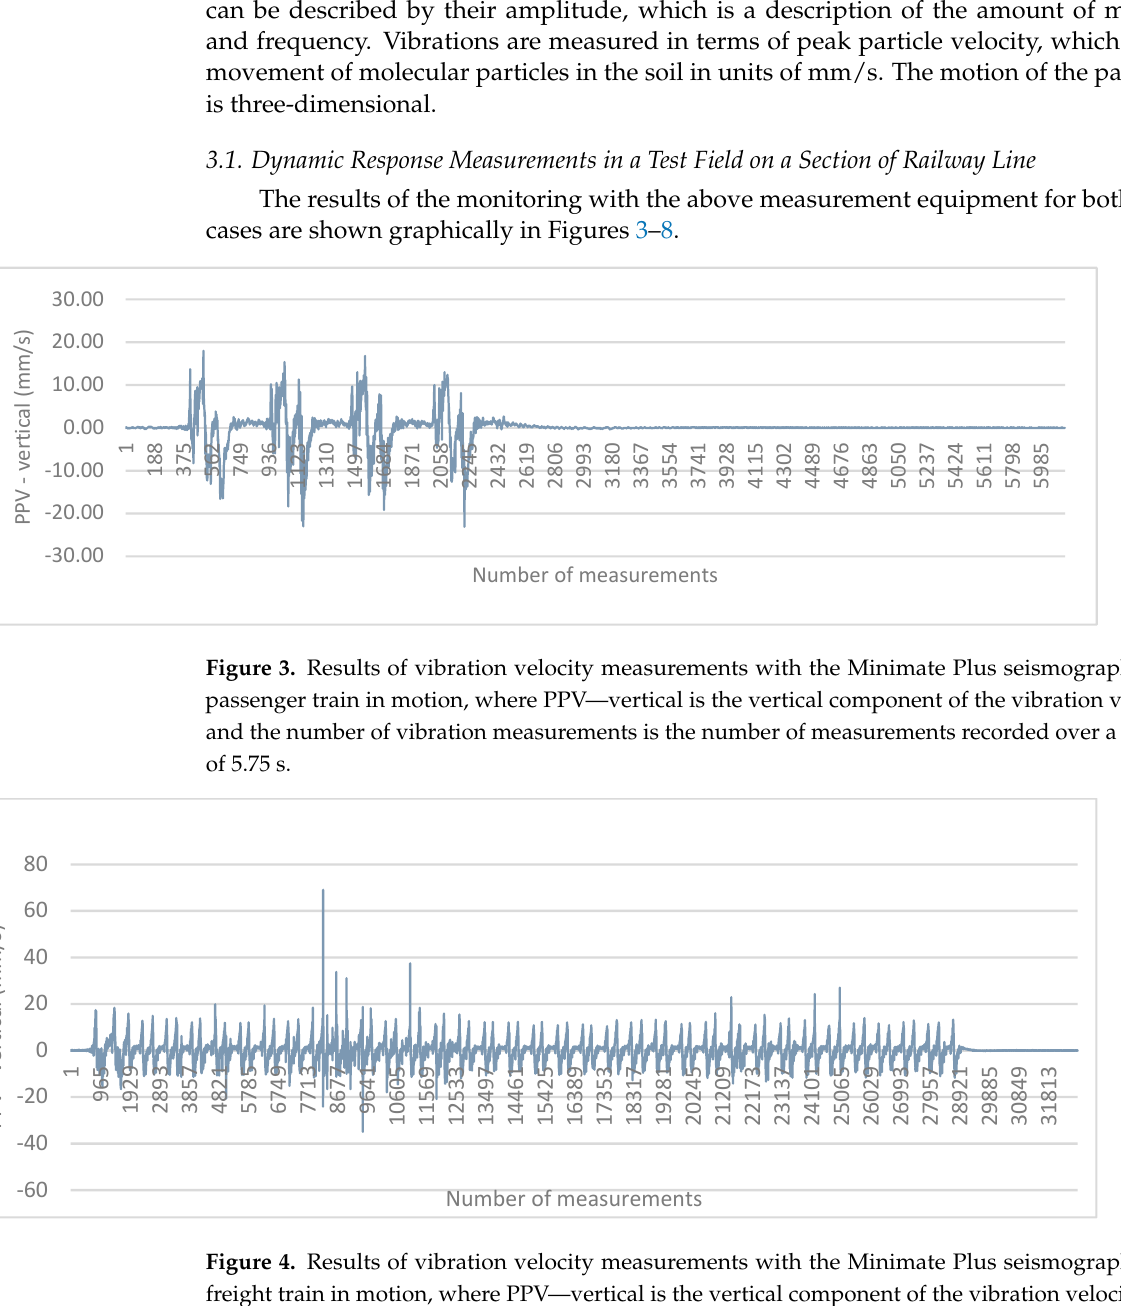
Figure 5. Results of a vertical displacement measurement with a Leica TS 50 RTS for a passenger train in motion. Figure 6. Results of a Leica TS 50 RTS vertical displacement measurement for a freight train in motion.